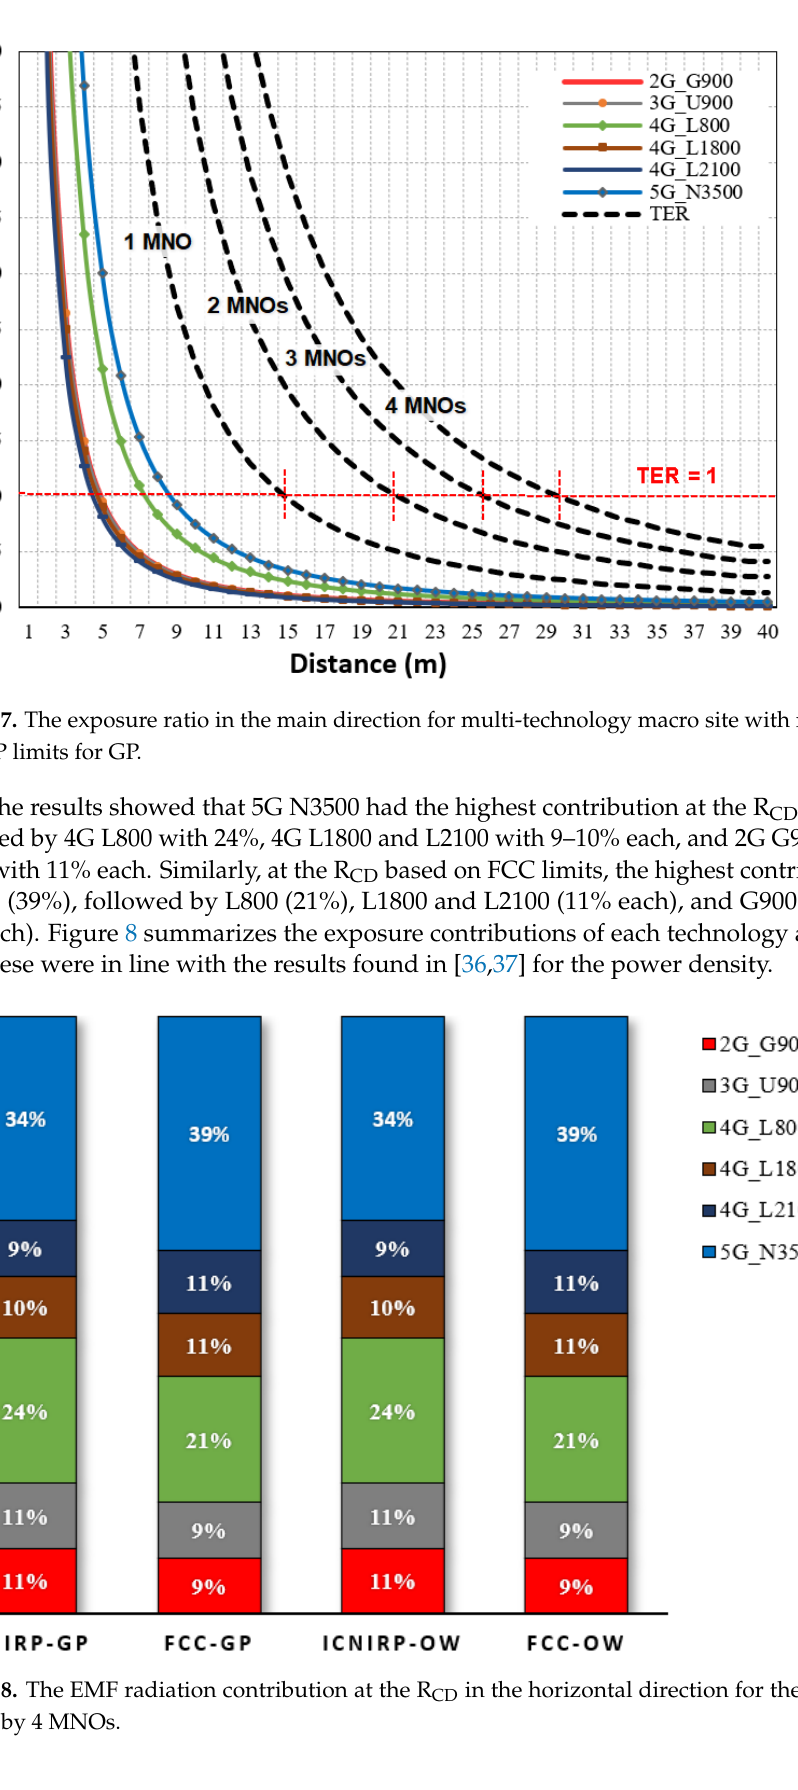
Figure 6. The power densities (W/m 2 ) in the main direction for the macro site shared by 4 MNOs.